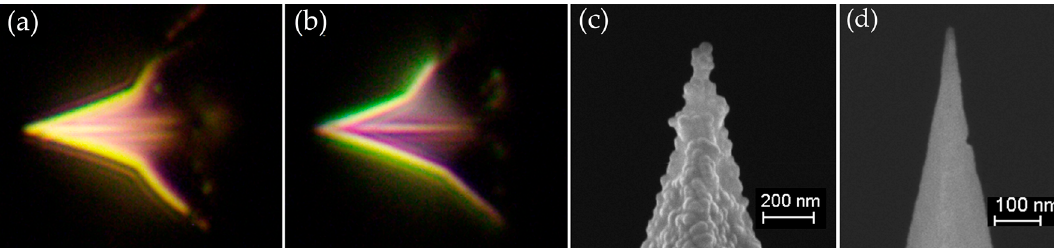
Figure 2. Dark-field images of TERS probes ( a ) without refractive index modification and ( b ) with refractive index modification by precoating with a 10 nm-thick layer of Al 2 O 3 . ( c ) SEM image of the refractive index-modified Ag-coated TERS probe. The Ag particle diameter at the tip apex is about 50 nm. ( d ) SEM image of a Si AFM probe before Ag coating.